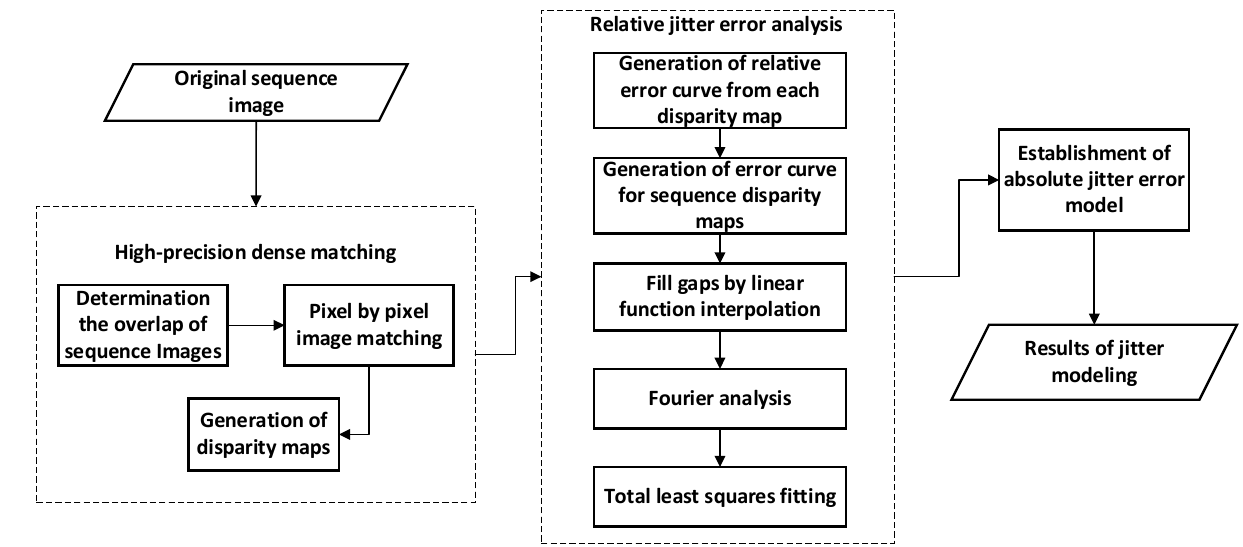
Figure 3. Flowchart of jitter detection using sequence CMOS images by rolling shutter.